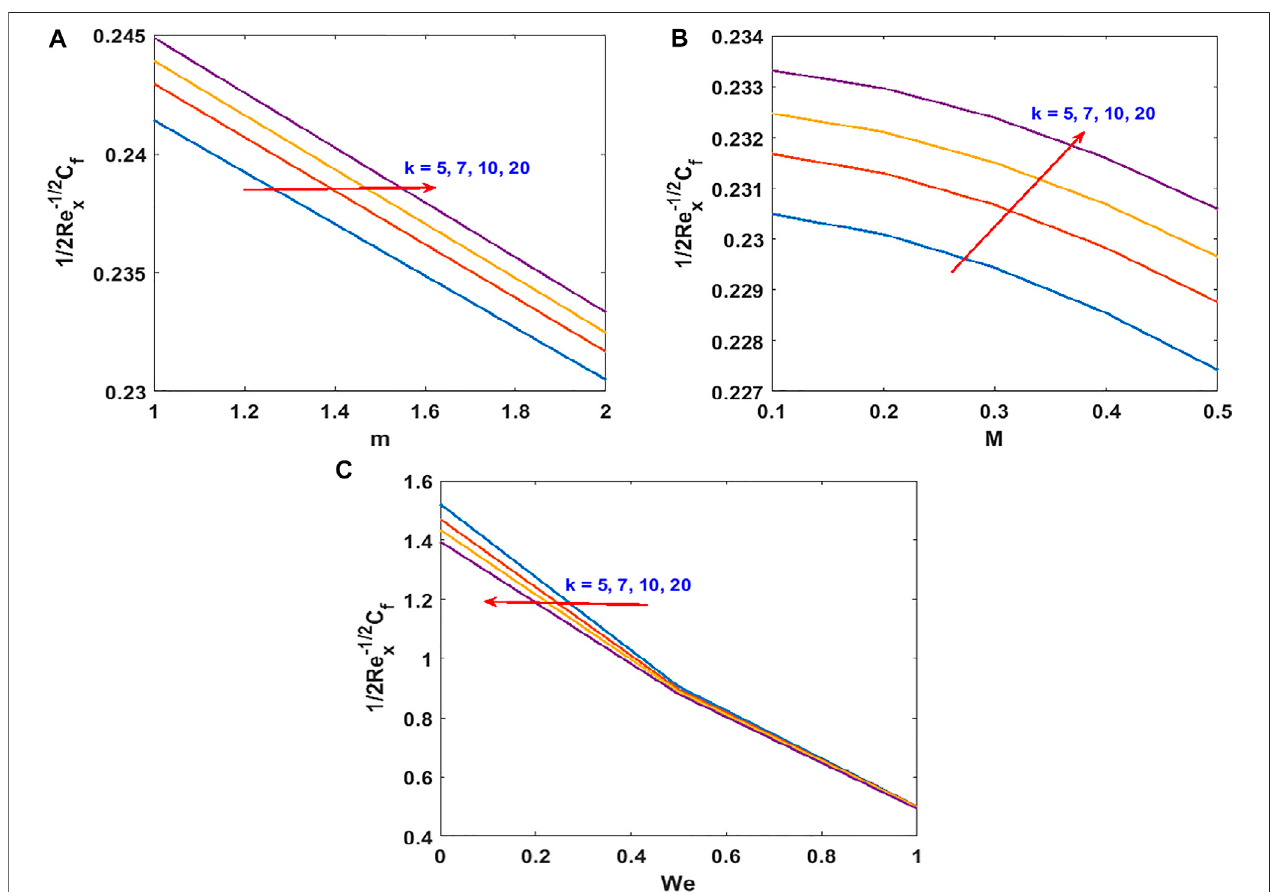
FIGURE 7 | Variation of Surface drag force on curvature parameter k against m, M, and We.